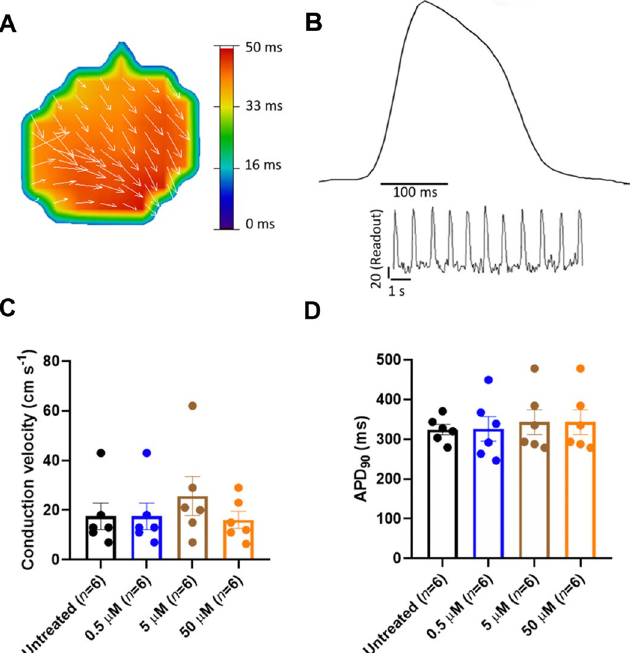
Figure 7. Conduction velocity and APD 90 after treatment of human iPSC-derived cardiomyocytes with the SERCA activator CDN1163. ( A ) Representative impulse propagation during the spontaneous activity of untreated monolayer syncytium formed of human iPSC-derived cardiac cells. Impulse propagation is represented by the activation maps of action potential propagation at different activation times, with the arrows showing the direction of the propagation wave across the monolayer syncytium. ( B ) Representative trace of the spontaneous action potential (AP) obtained by optical mapping of a syncytium formed by human iPSC-derived cardiomyocytes. The inset represents single-pixel signals of spontaneous optical AP recordings. ( C ) Conduction velocity (CV) calculated from each activation map in the presence and absence (untreated control) of CDN1163. We found no significant changes in CV between the control and treatment groups. ( D ) Quantification of APD 90 from optical mapping readings shown in panel ( B ). We found that treatment of human iPSC-derived cardiomyocytes with CDN1163 does not have significant effects on the APD90 compared to the untreated control. Data are reported as mean ± SEM ( n = 6). Groups were compared using a one-way analysis of variance (ANOVA) with the Dunnett test; statistical significance was set at p <